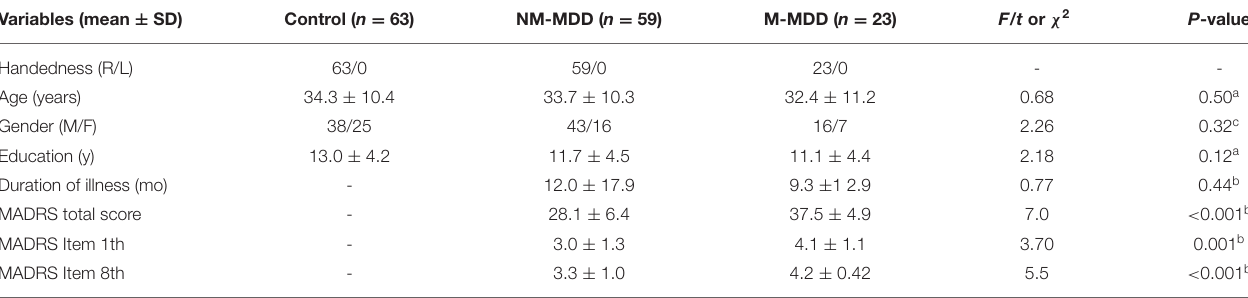
TABLE 1 | Demographic and clinical characteristics of all